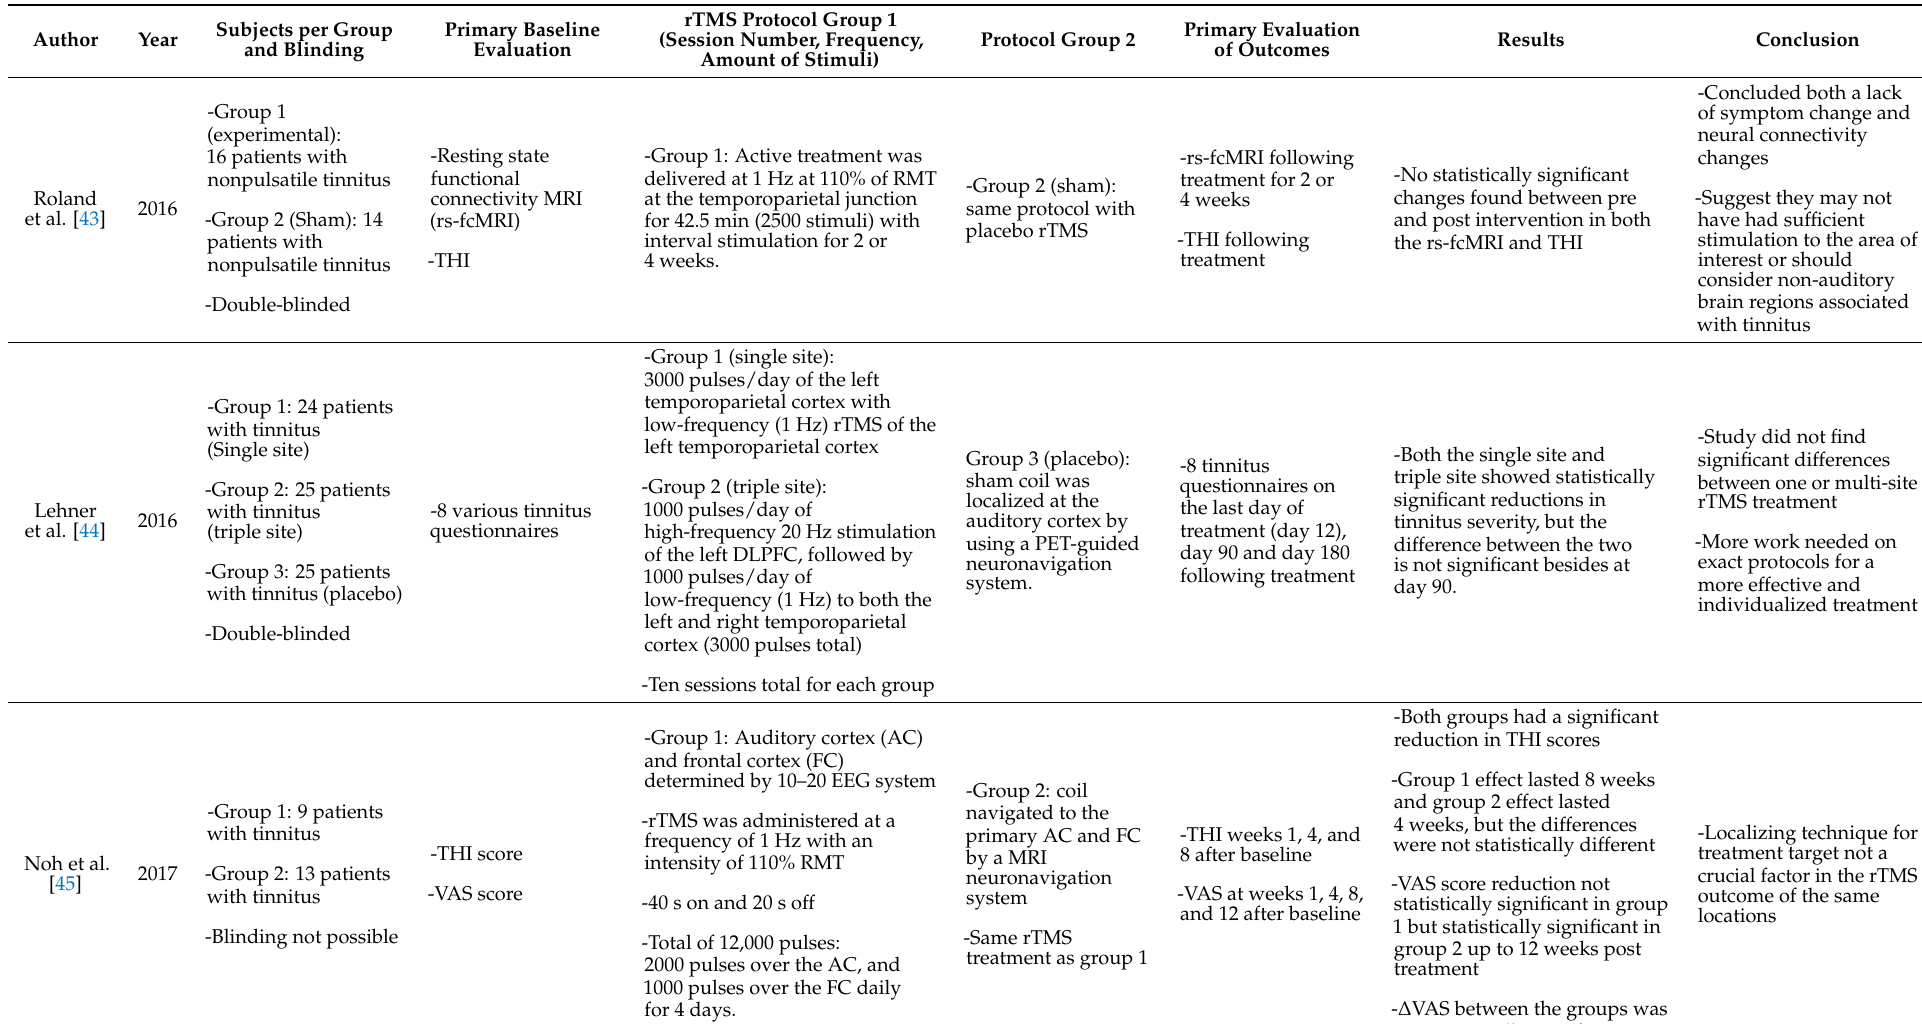
Table 2. Randomized-controlled trials: Summary of characteristics protocols, results, and conclusions in 11 RCTs utilizing rTMS on patients with